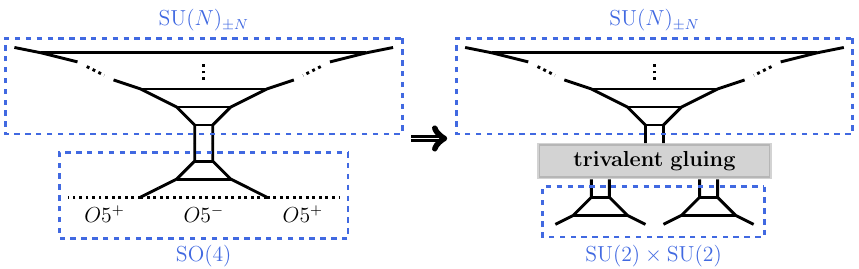
Figure 3 . A transition from a 5-brane web with an O 5-plane to a web-like diagram with trivalent gluing. The left (cid:12)gure represents a 5-brane web of the pure SO(2 N + 4) gauge theory using an O 5-plane. The right (cid:12)gure is a web-like description by replacing the 5-brane for the SO(4) gauge theory part in the left (cid:12)gure with the two 5-branes webs of the pure SU(2) gauge theory with no discrete theta angle. Now the three 5-brane webs are connected by the trivalent gluing.